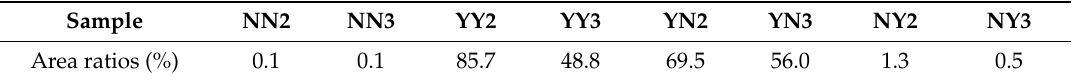
Table 3. Area ratios of the residual silicone rubber of eight samples.